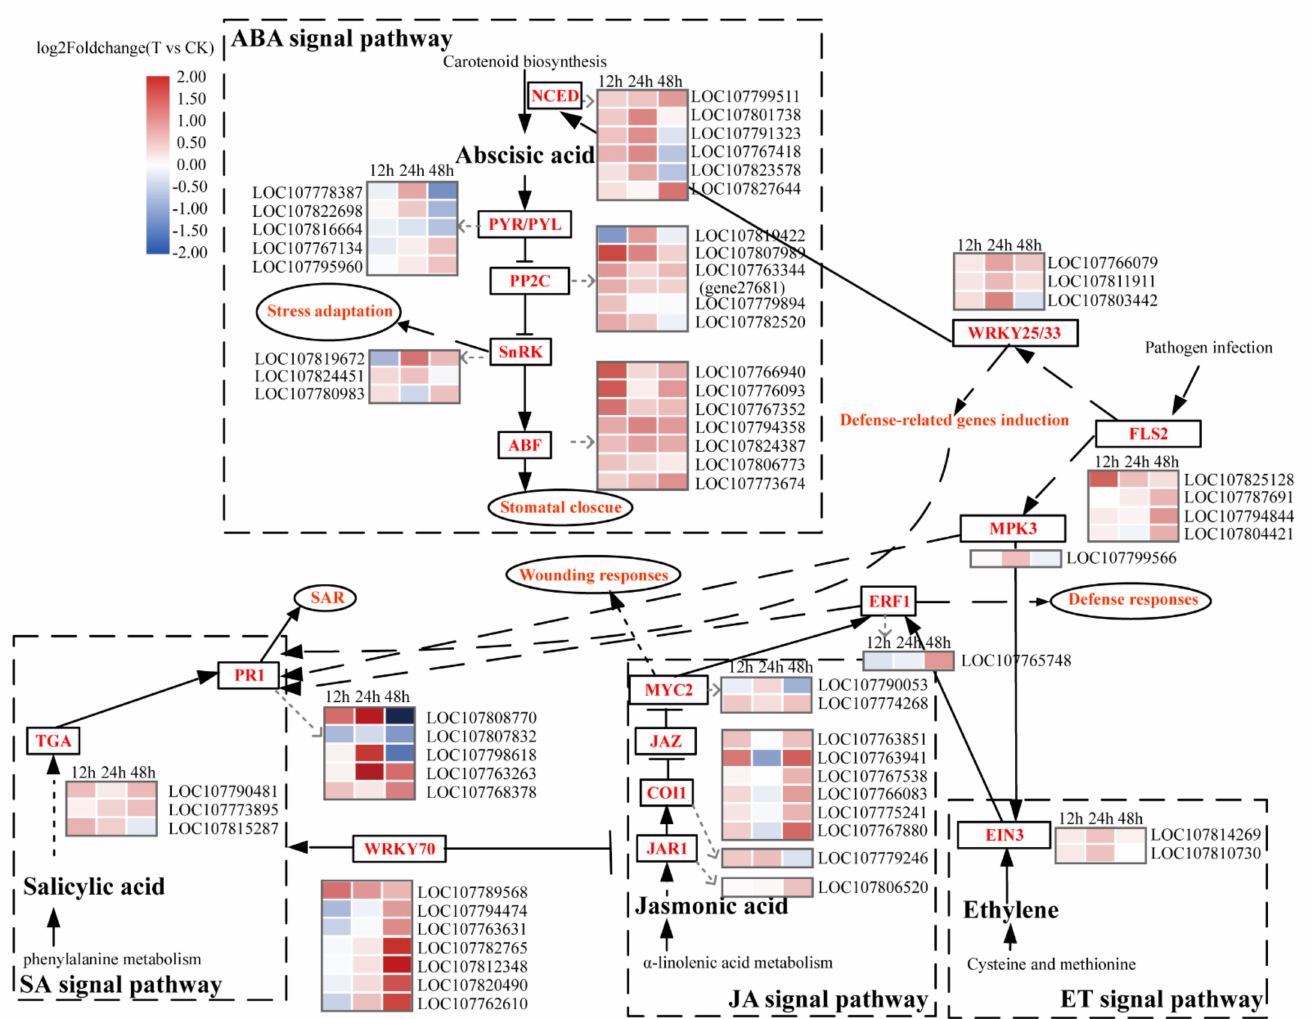
Figure 8. Different expression of key genes related to the ABA, SA, JA and ET signaling pathways. The heatmap data were log 2 fold changes of DEGs that were significantly differentially expressed at least at one time